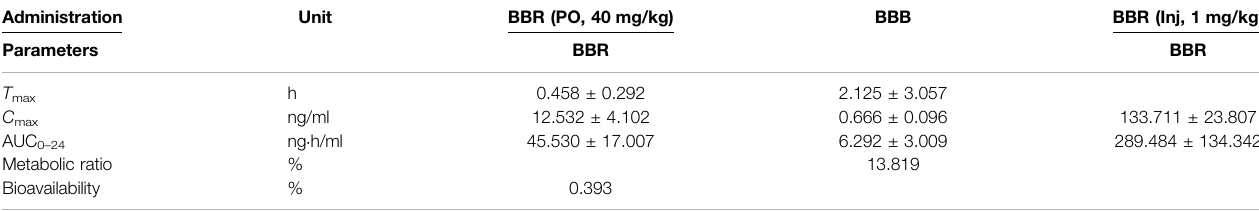
TABLE 2 | Pharmacokinetic parameters of BBR and its metabolism following oral administration (40 mg/kg) and intravenous injection (1 mg/kg). Administration